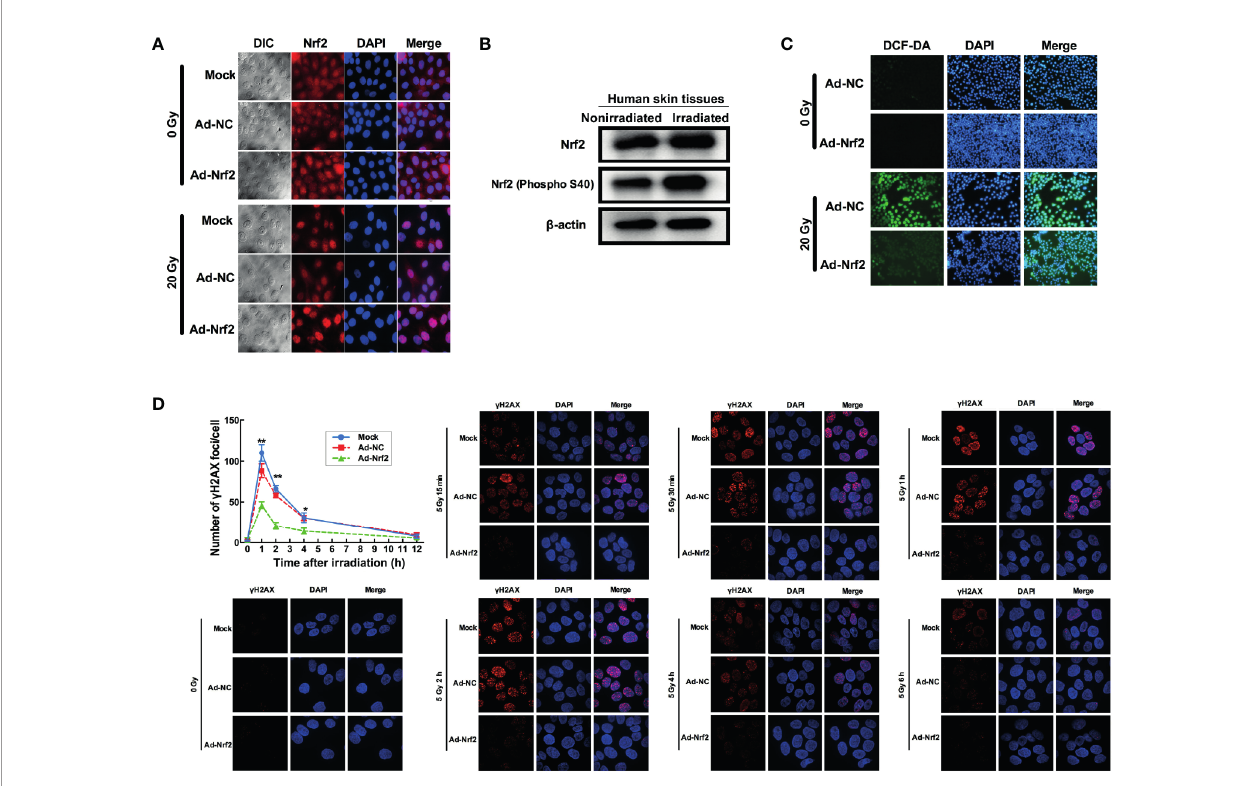
FIGURE 2 | Nrf2 confers protection against radiation in skin cells. (A) Immuno fl uorescence assay detecting Nrf2 translocation after irradiation and Nrf2 overexpression. (B) Western blot analysis of Nrf2 and phosphorylated Nrf2 (S40) after irradiation. (C) ROS levels in skin cells after IR and Nrf2 overexpression were detected using an ROS-sensitive DCF-DA probe. (D) The dynamic repair process of DNA DSBs was measured by detecting nuclear gH2AX foci at several time points after 5 Gy of X-ray irradiation. * means p < 0.05, ** means p <